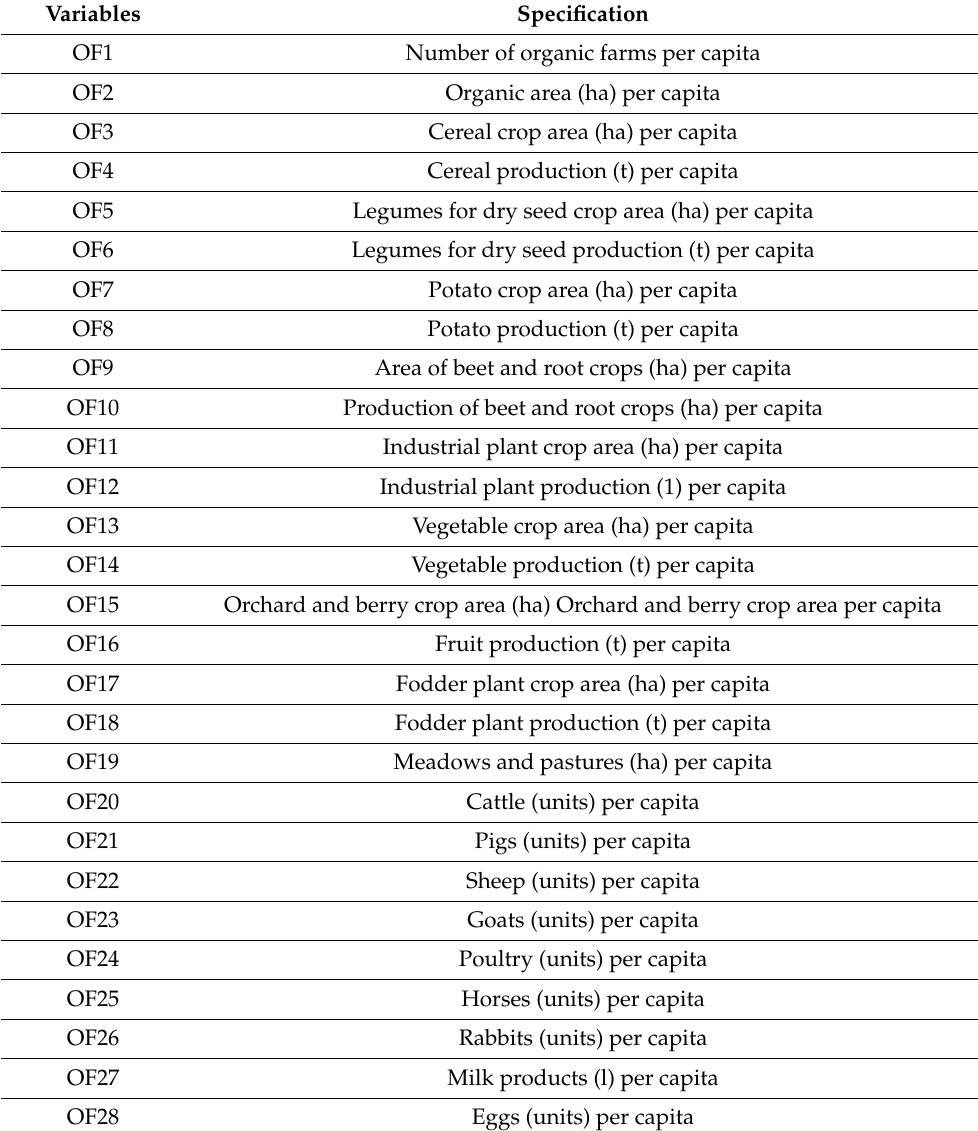
Table 1. Variables describing the organic farming